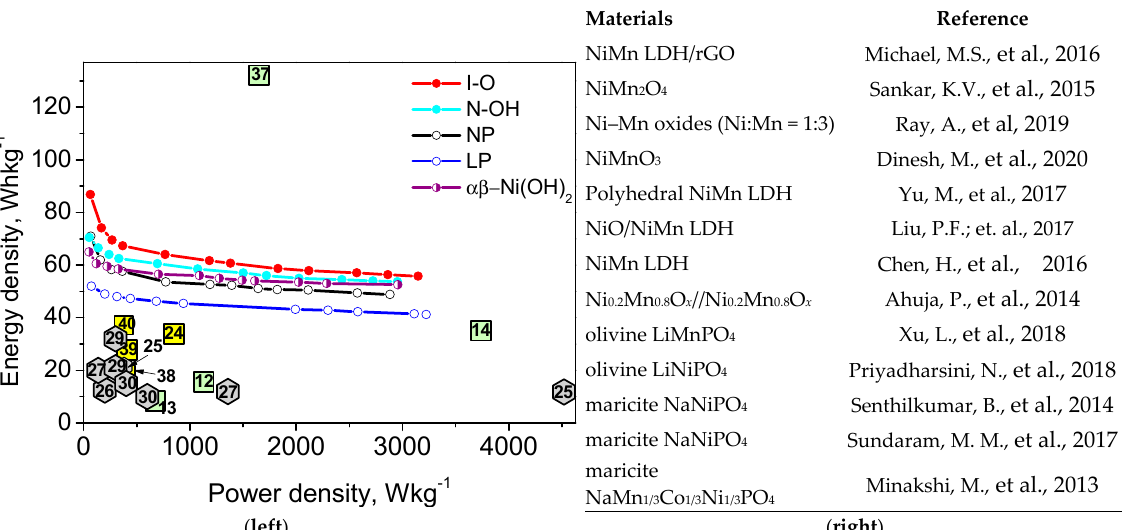
Figure 7. ( left ) Energy density versus power density (Ragone plot) for supercapacitors with different composite electrodes. The literature data for oxides, hydroxides and phosphates are indicated as , and , respectively ( right ). The used references are given in the figure: [12–14,24–27,29,30,37–40].